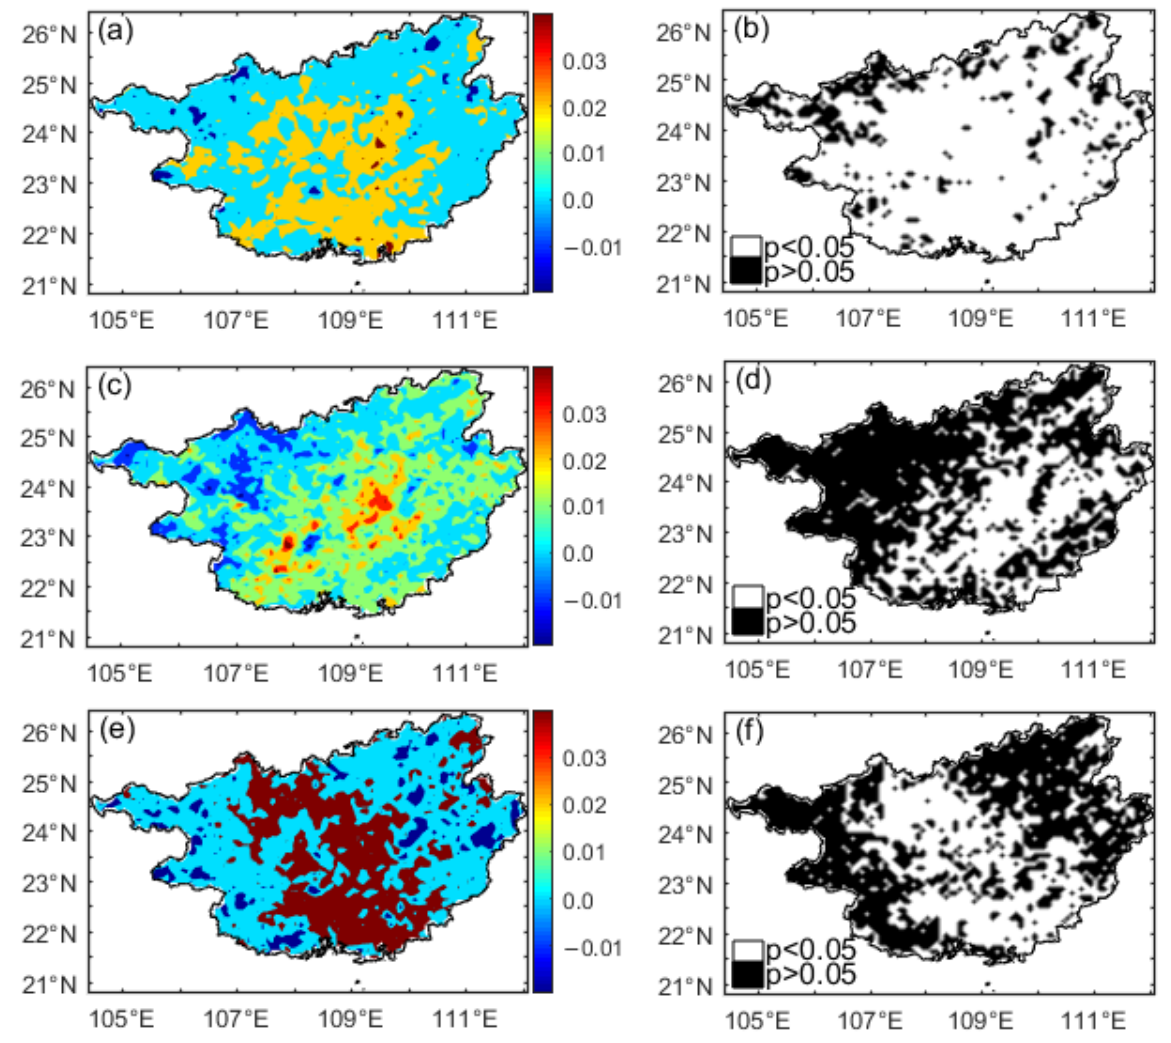
Figure 4. Spatial distributions of the trend rates of the annual NDVI (unit: 10 × year − 1 ) ( a , c , e ) and